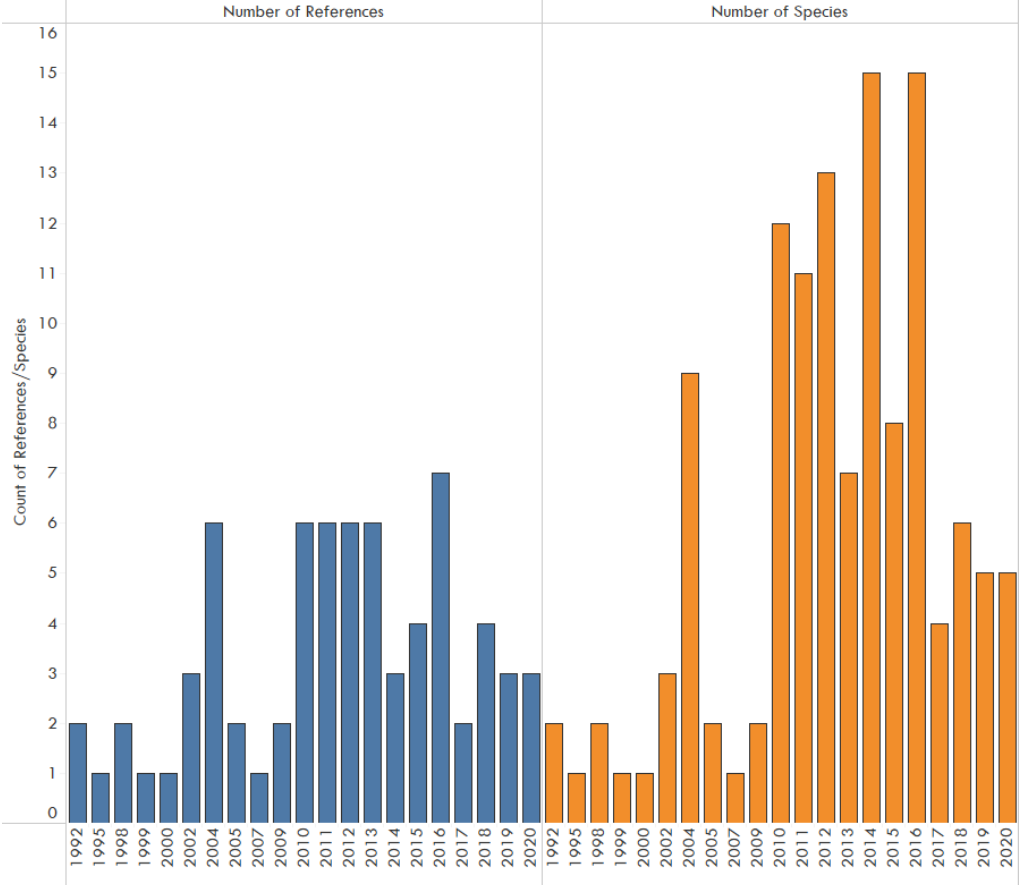
Figure 1. Number of references published and number of species affected by unique illegal trade events (a paper may refer to multiple species), focused on wet markets, bushmeat, pet, and other illegal trade, 1992–2020. Other illegal trade refers to illegal wildlife not originating as bushmeat, pet trade, or wet markets. Table 1. Pathogens including viruses, bacteria, fungi, endoparasites, and ectoparasites including genus and species when known, hosts affected, implicated illegal wildlife trade activity and zoonotic potential documented in the literature re- viewed, 1990–2020.